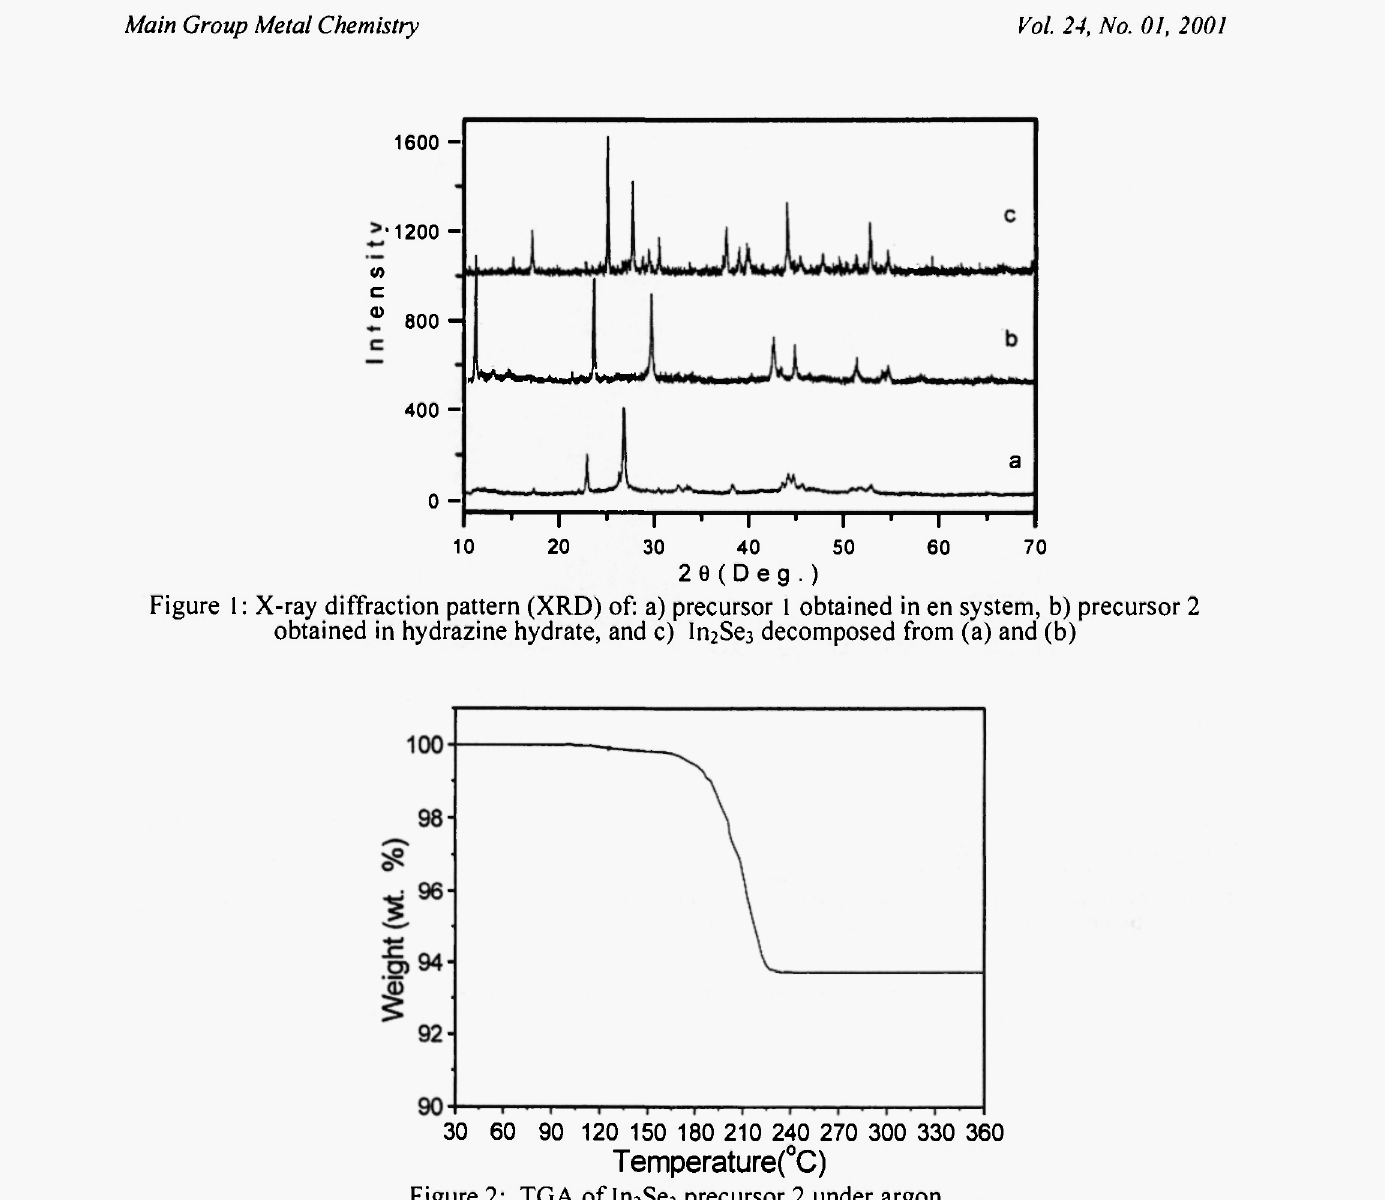
Figure 2: TGA of In2Se3 precursor 2 under